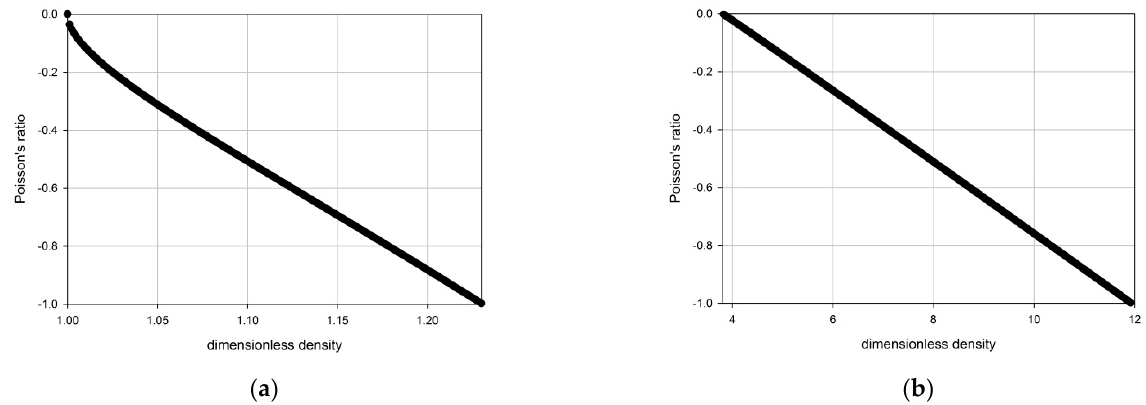
Figure 1. Variation of Poisson’s ratio vs. dimensionless density in auxetic media: ( a ) Equation (27a); ( b ) Equation (27b).